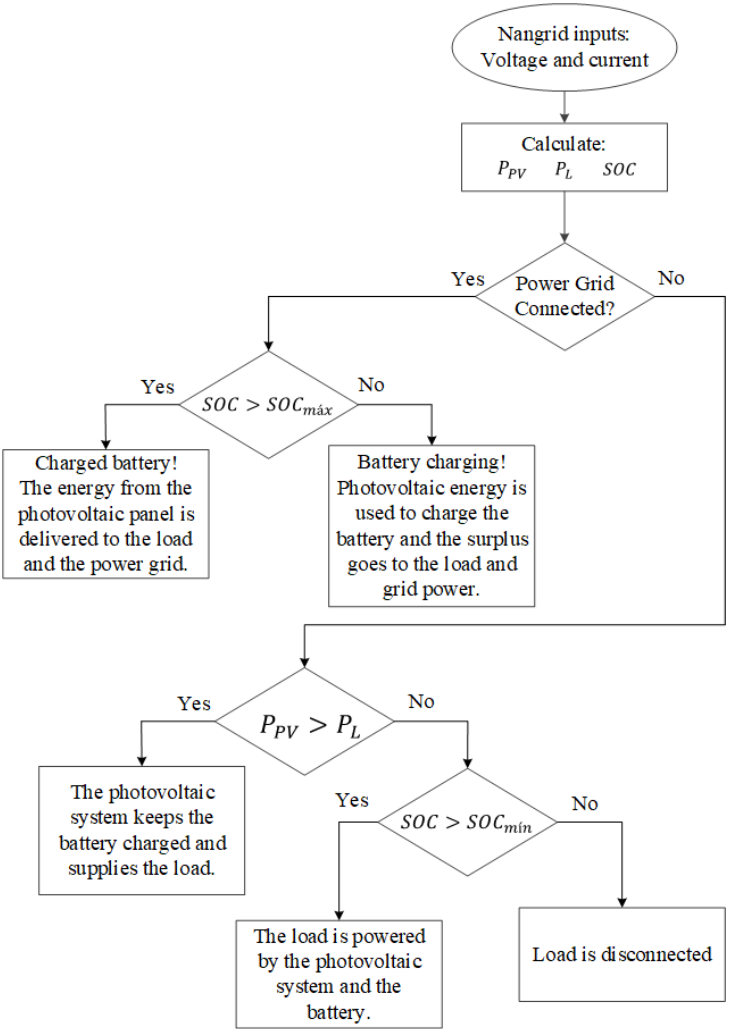
Figure 10. Nanogrid Management System